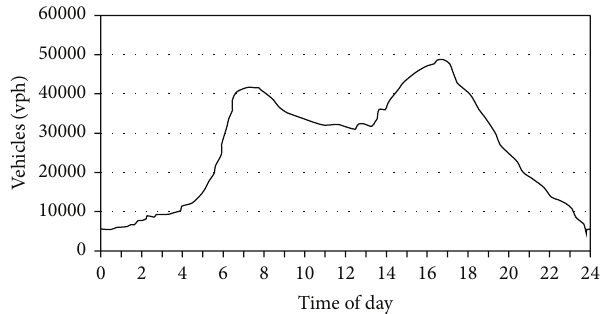
Figure 6: Typical traffic flow versus time of